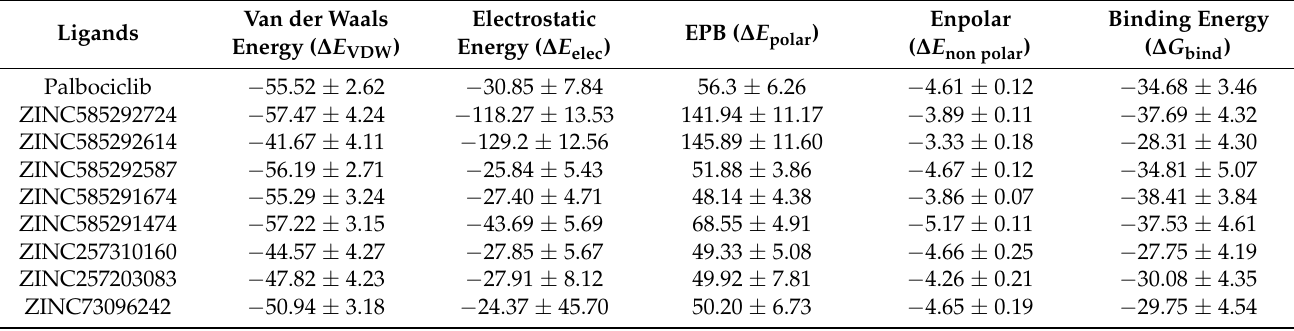
Table 5. The predicted binding free energy and the individual energy components (Kcal/mol) for the ligand–CDK4 complexes.